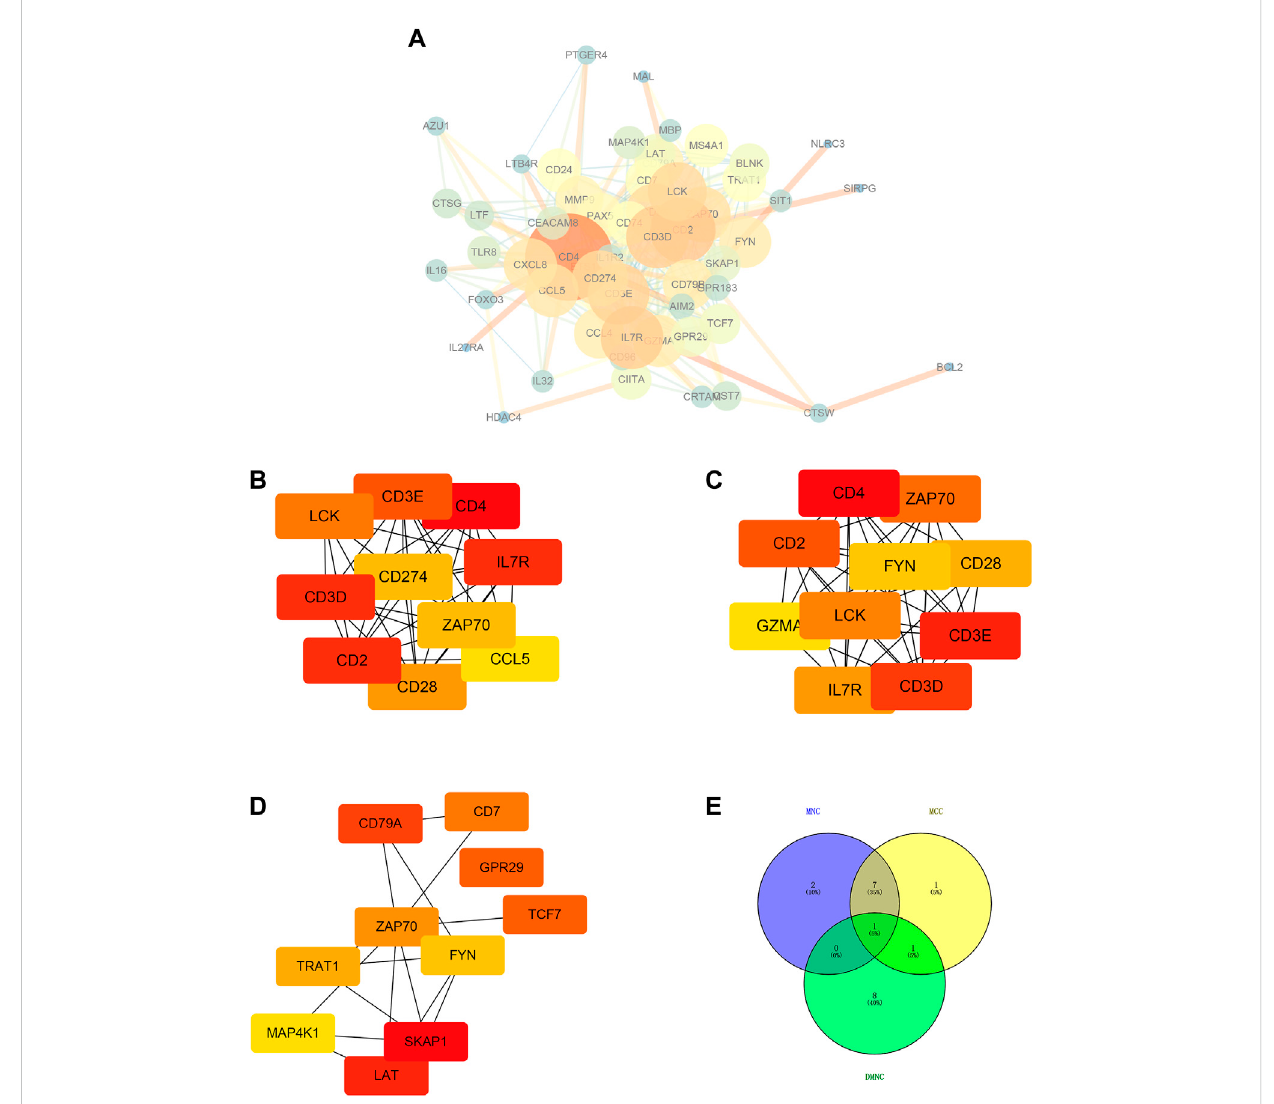
FIGURE 5 Hub genes screening based on PPI network of immune-related genes. (A) Protein-protein interaction (PPI) analysis based on STRING tool. Cytoscape software was used for visualization. The larger the genes involved, the larger the degree of nodes, and the thicker the lines, the larger the numberofbetweenness. (B) Toptenhubgenes(LCK,CD3E,CD4,CD3D,CD274,IL7R,ZAP70,CD2,CCL5,andCD28)screenedbasedonMNCalgorithm. (C) Toptenhubgenes(CD4,ZAP70,CD2,FYN,CD28,GZMA,LCK,CD3E,IL7R,andCD3D)screenedbasedonMCCalgorithm. (D) Toptenhubgenes (CD79A,CD7,GPR29,ZAP70,TCF7,TRAT1,FYN,MAP4K1,SKAP1,LAT)screenedbasedonDMNCalgorithm. (E) Intersectionofhubgenesscreenedbythe above three